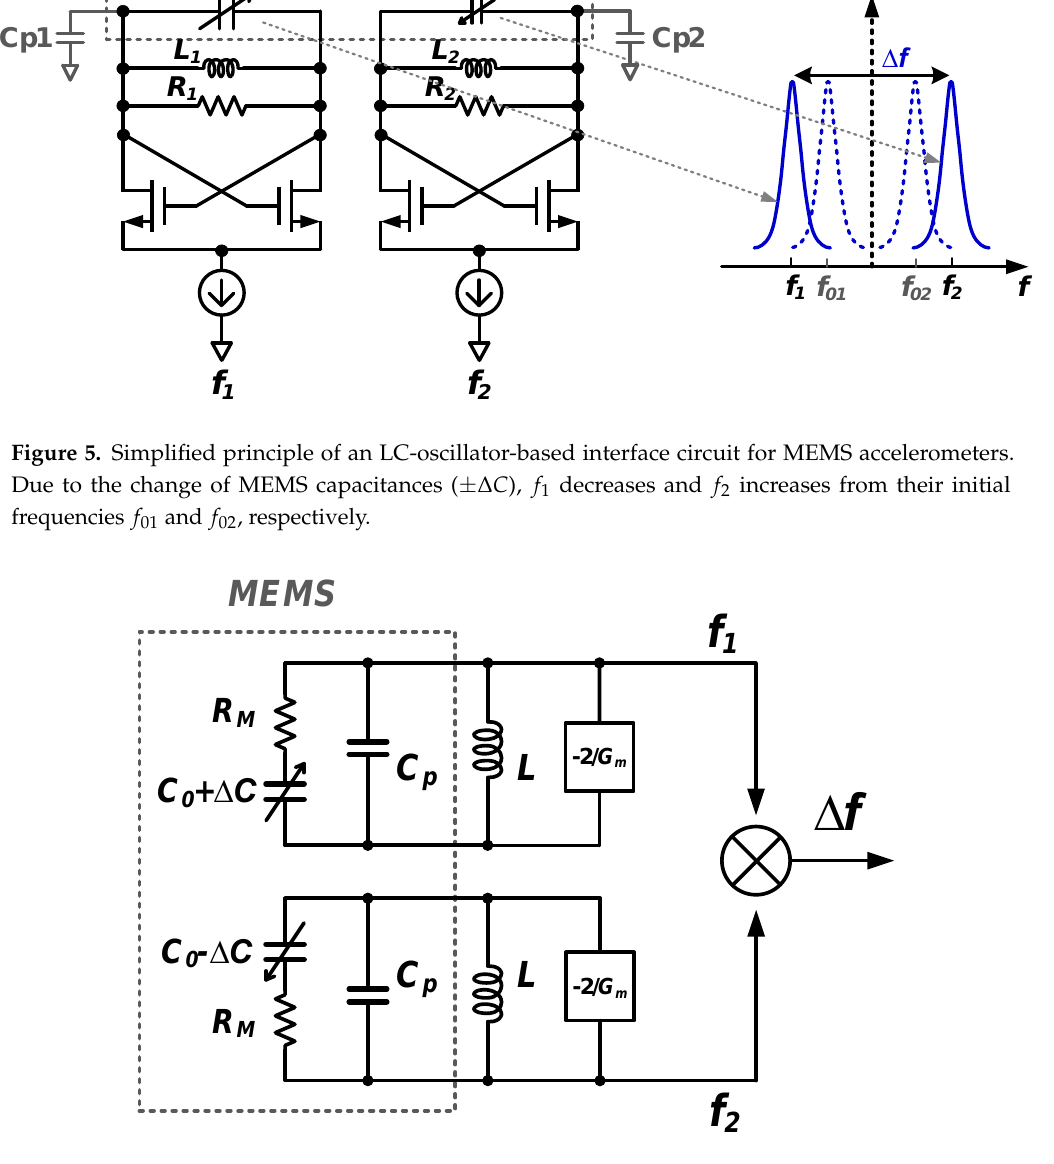
Figure 6. Simplified LC-oscillator-based front-end circuit for noise analysis. Here, G m is the transconductance of one of the cross-coupled NMOS transistors in Figure